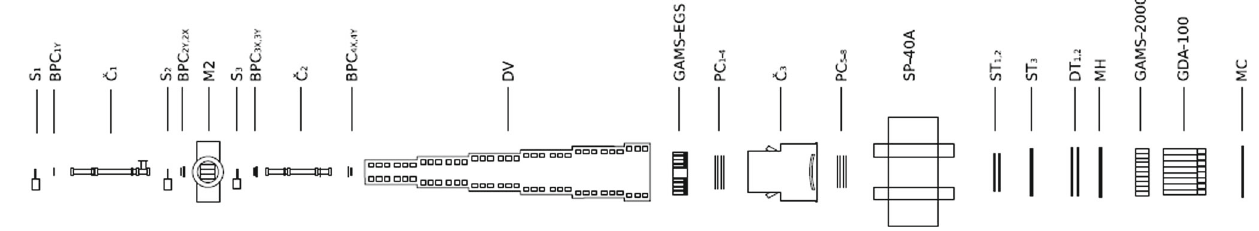
ture constant, F K is K + decay constant ( F K = 155 . 6 ± is the K μ 2 decay width. 0 . 4 MeV [3]) and Γ K μ 2